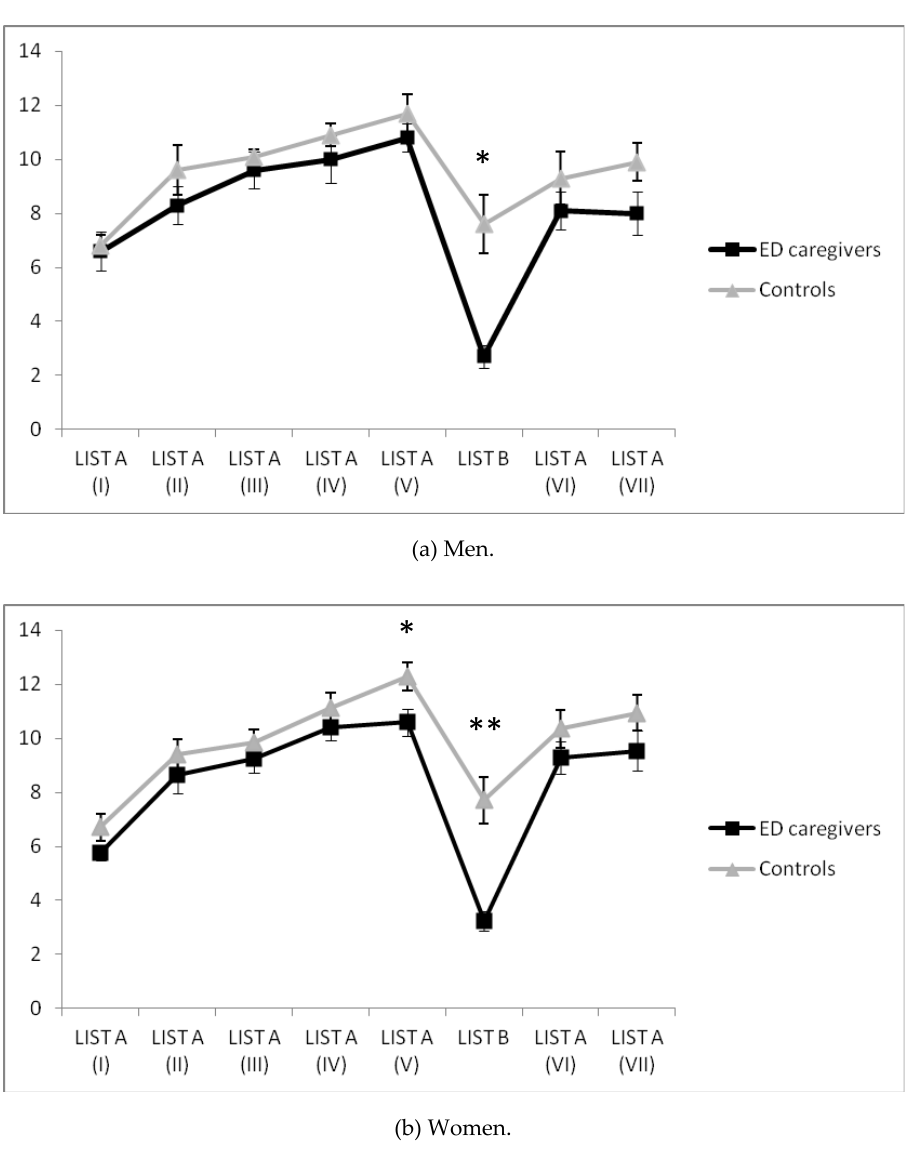
Figure 2. Verbal memory performance in ED caregivers and control groups for women ( a ) and men ( b ) * p < 0.05; ** p < 0.01.